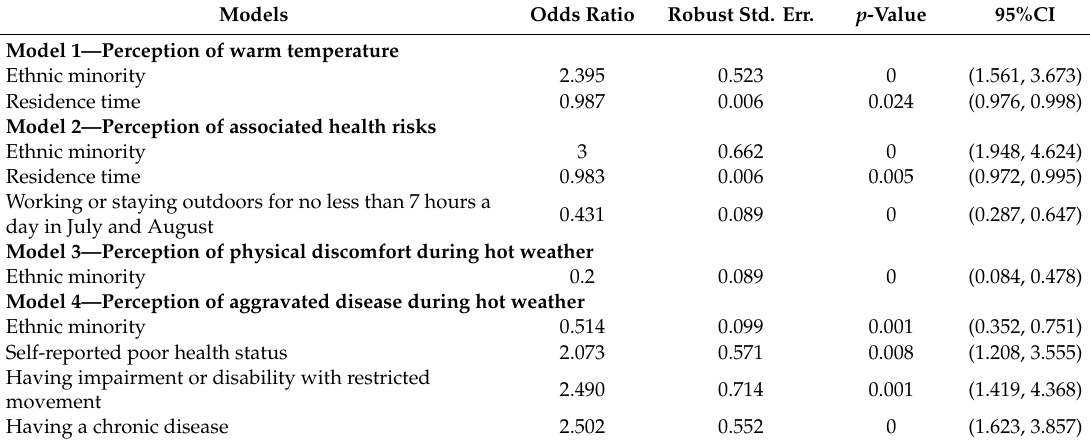
Table 3. Logistic regression results on perceptions.